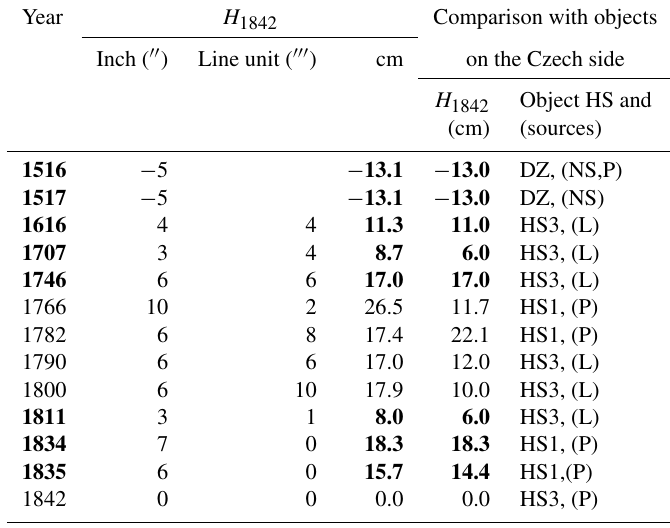
Table 10. Compilation of the Czech DMs (Neue Schriften, 1845). Year H 1842 Comparison with objects Inch ( (cid:48)(cid:48) ) Line unit ( (cid:48)(cid:48)(cid:48) ) cm on the Czech side